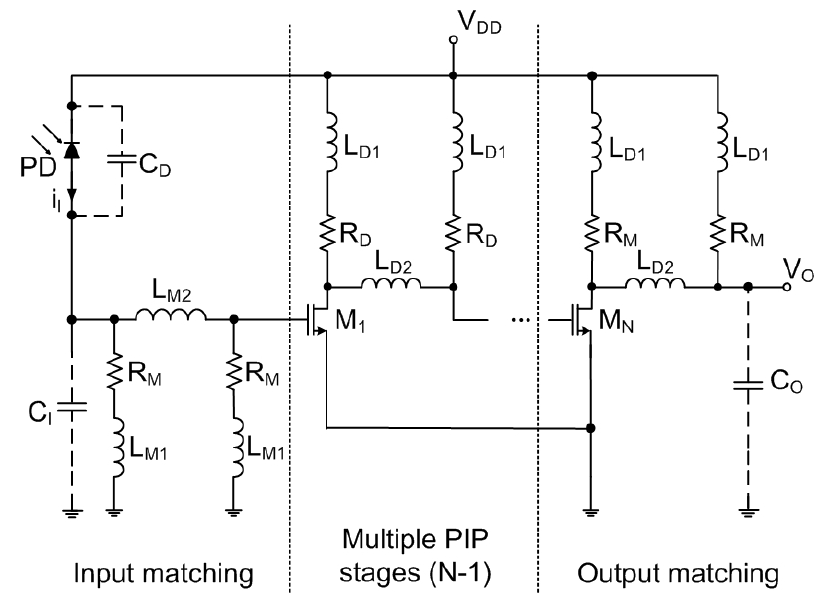
Figure 13. Six cascaded CS stages TIA with